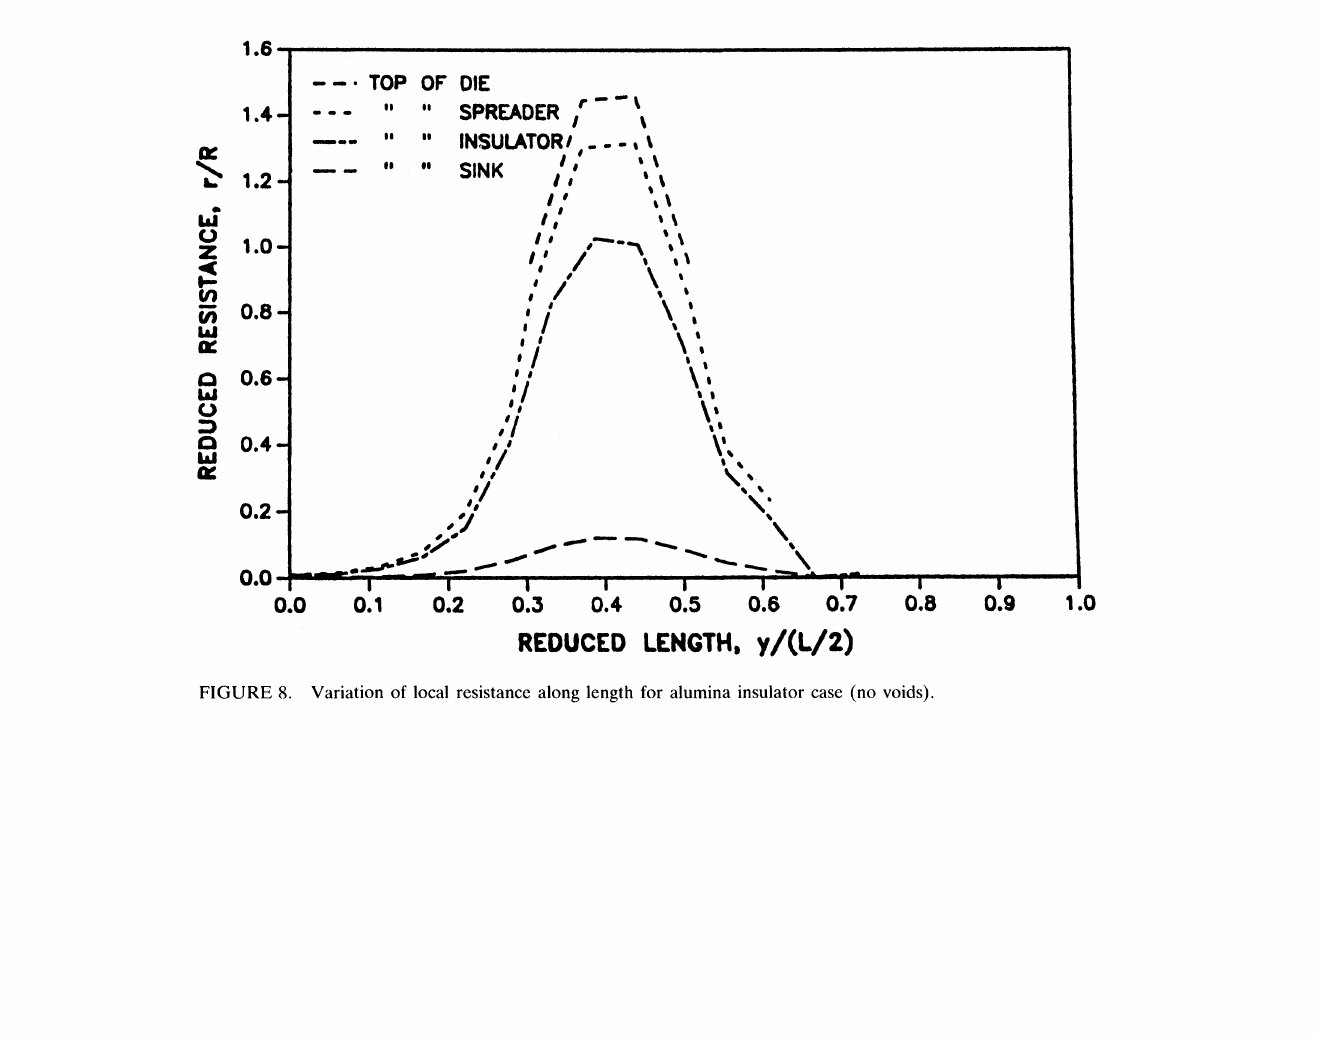
FIGURE. 7. Variation of local resistance along width for alumina insulator case (no voids).